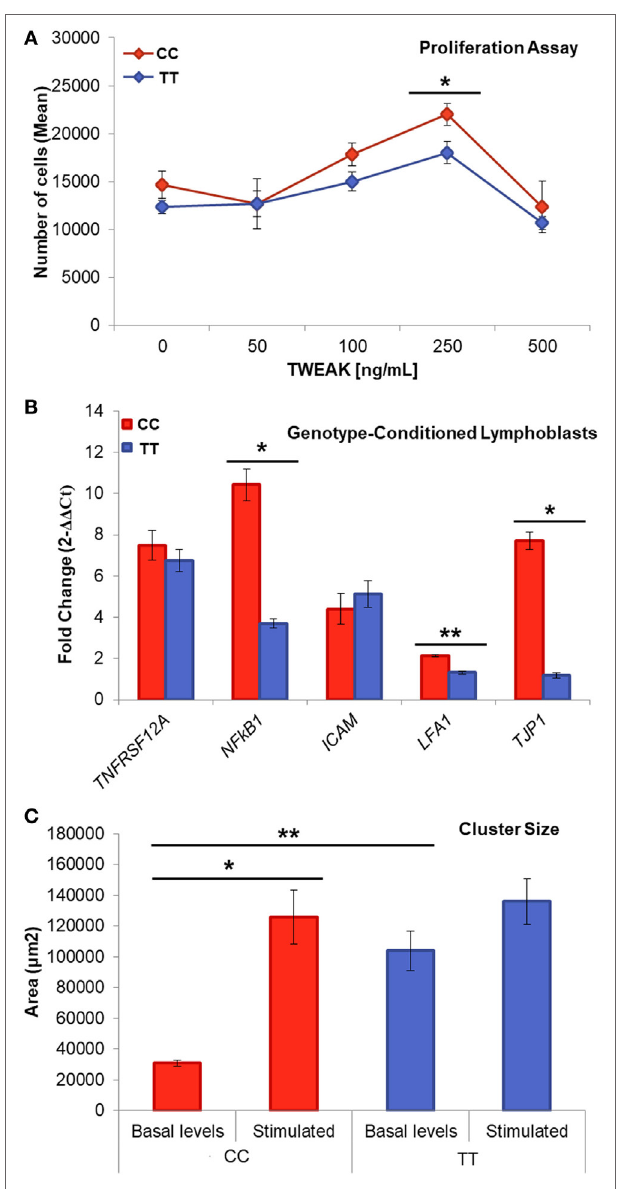
FigUre 3 | Genotype-conditioned lymphoblastoid cell lines (LCL) for rs4947296. (a) Proliferation assay of homozygous LCL treated with tumor necrosis factor-like weak inducer of apoptosis (TWEAK; 0, 50, 100, 250, and 500 ng/mL) and measured using PrestoBlue ™ (* p < 0.05). Comparisons between groups were achieved using a two-sided Student’s t -test. (B) Relative gene expression according to the genotype, after treatment with 250 ng/mL of TWEAK, p -values: TNFRSF12A = 0.44; NFKB1 = 1.36 × 10 − 4 ; ICAM = 0.91; LFA-1 = 5 × 10 − 6 ; TJP1 = 3.2 × 10 − 5 (* p < 1 × 10 − 4 , ** p < 5 × 10 − 6 ) (c) Cluster size within LCLs with and without stimulation (** p = 5 × 10 − 7 , * p = 0.02). CC, risk genotype; TT, protective